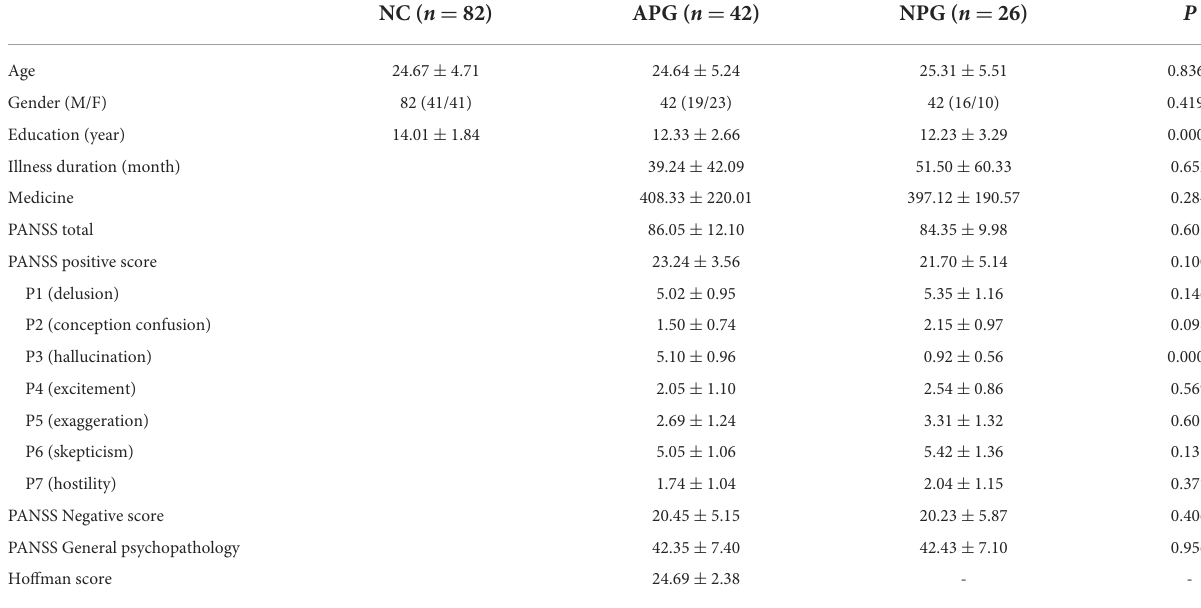
TABLE 1 Demographics and clinical characteristics of the